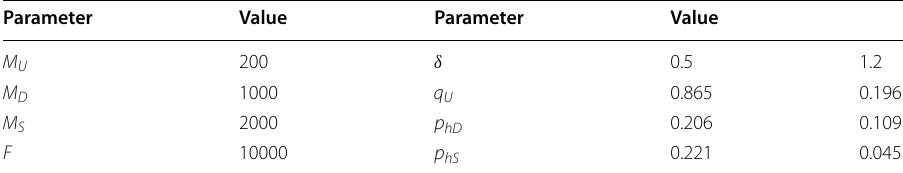
Table 3 Caches parameters and hit probabilities for different values of δ